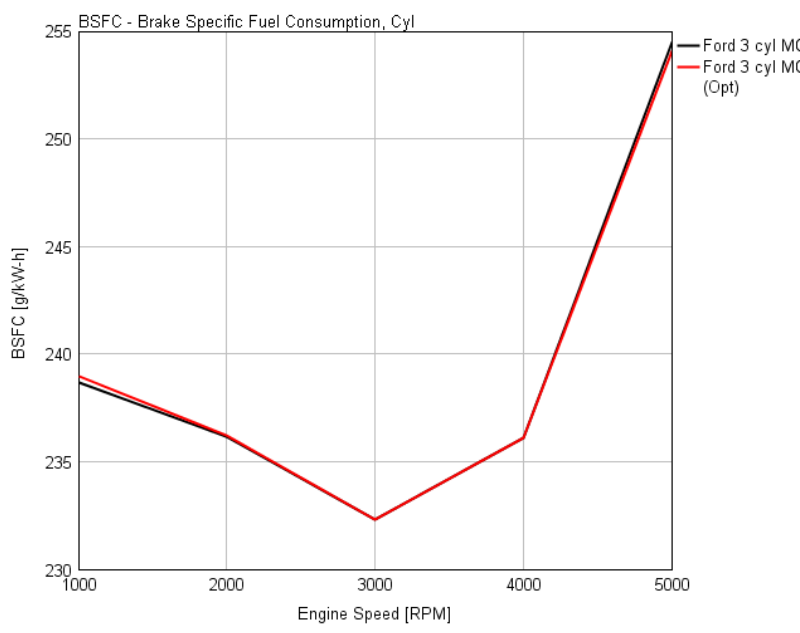
Figure 20. BSFC graphs for the initial and optimized EAT 1 kW models.